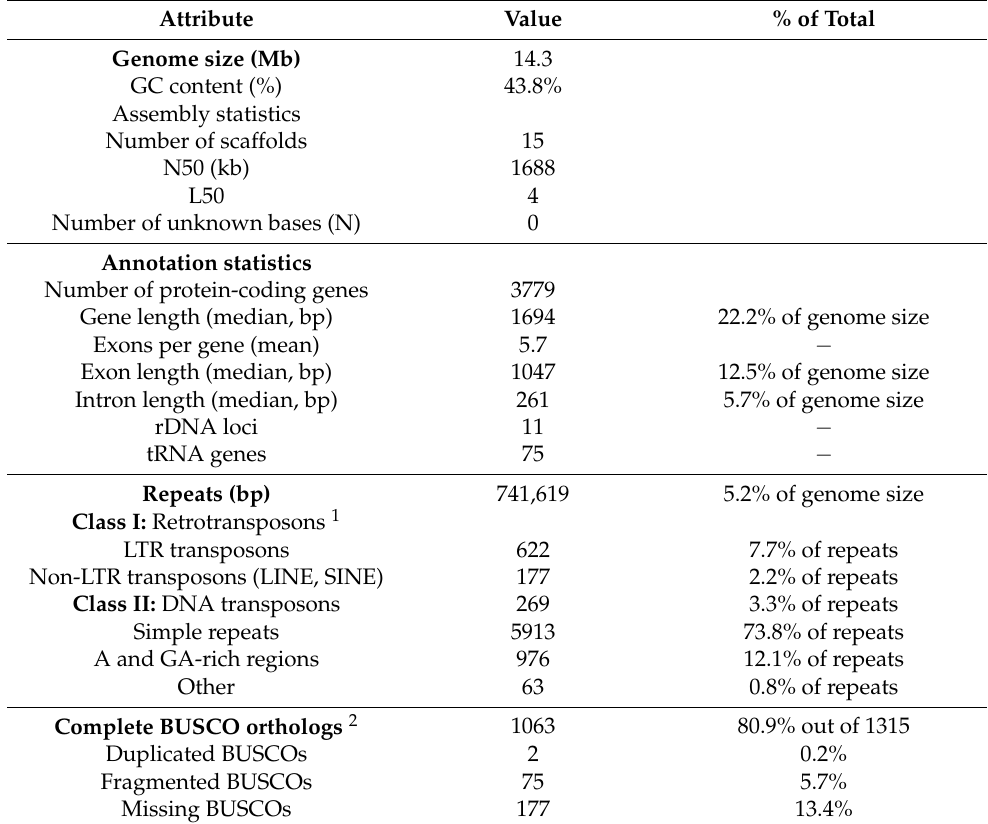
Table 2. Genome statistics of the Novakomyces olei sp. nov.